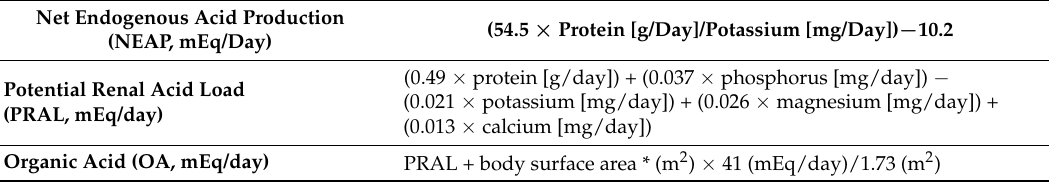
Table 1. Estimates of the net endogenous production of acids from dietary